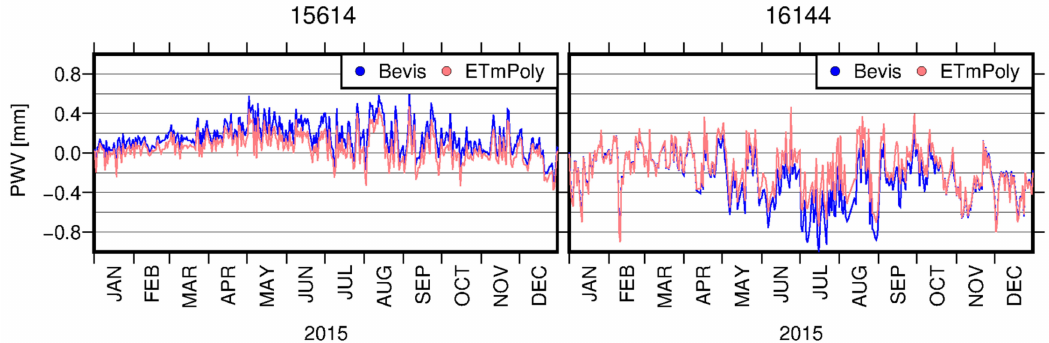
Figure 7. Di ff erences between PWV estimated using Bevis (blue) and ETmPoly (pink) coe ffi cients and PWV obtained directly from the RS measurements, for 15614 (left) and 16144 (right) RS